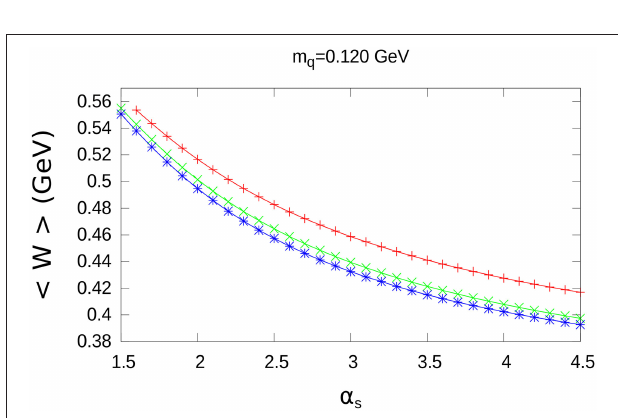
FIGURE 8 | Value of W as a function of α s . The same conventions as in the previous figures are used.